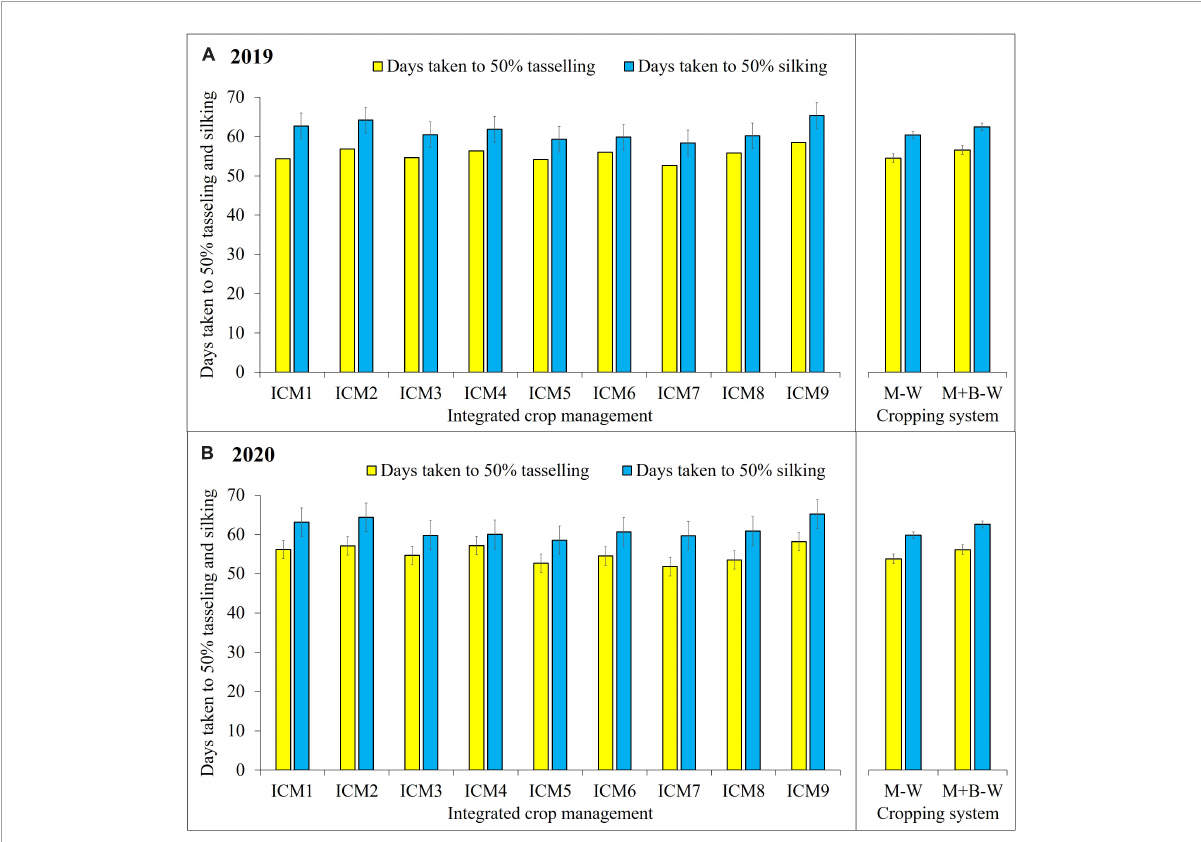
FIGURE2 Effect of different ICM modules and cropping system on days taken to phenological stages of maize 2019 (A) and 2020 (B) . The LSD 0 . 05 is indicated by a bar above each column, and any treatment difference beyond the range of bar within each year is significantly